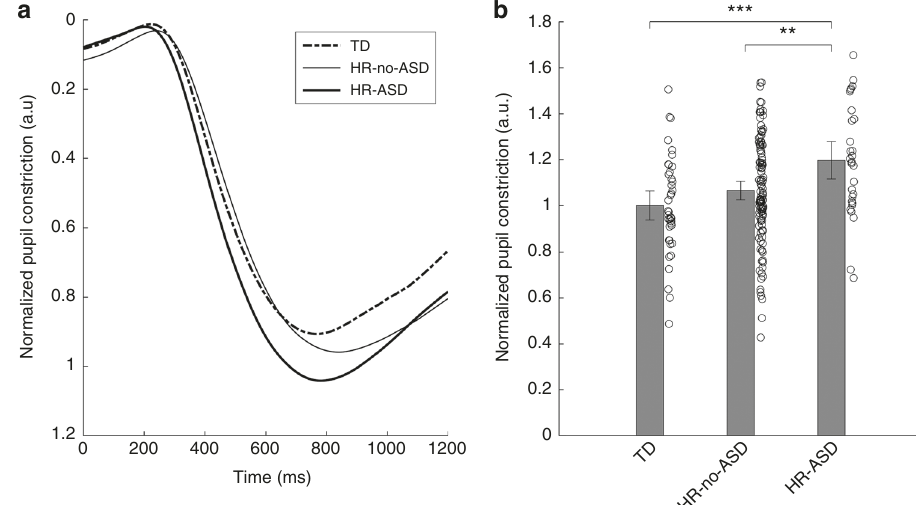
Fig. 1 Stronger PLR in infancy is associated with ASD diagnosis at three years of age. a Average pupil traces for all infants expressed as the site-normalized relative constriction of the pupil following the stimuli onset at 0 ms. b Mean relative constriction normalized within site by dividing with the TD group average (see main text), together with individual data points. Error bars are 95%